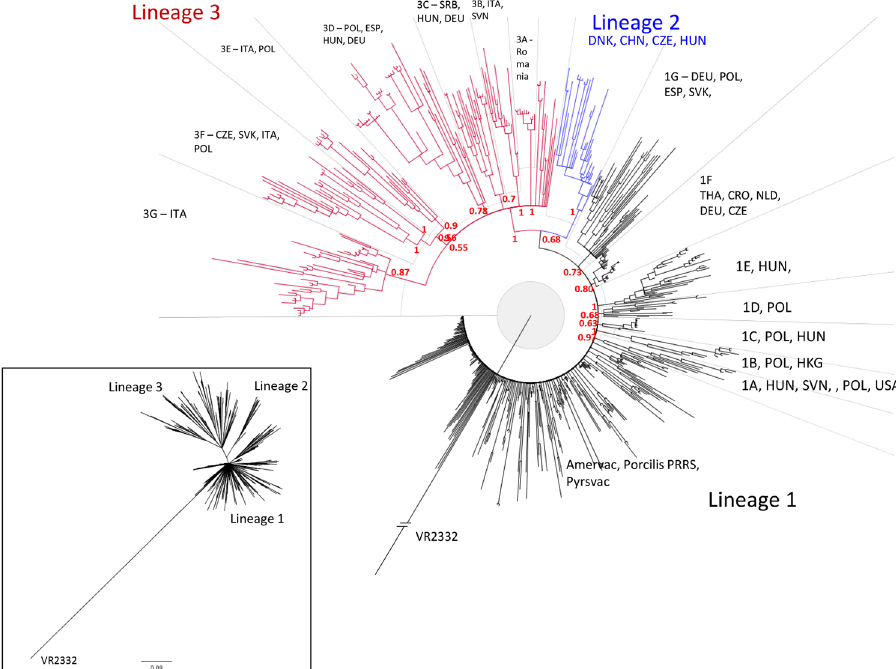
Figure 2. Phylogenetic tree of PRRSV 1 Subtype 1 ORF5 sequences constructed in MrBayes 40 . PRRSV 2 prototype strain VR2332 (AY150564) was used as an outgroup. Three main genetic lineages were distinguished, lineages 1 and 3 containing further clades 1A–1G and 3A–3G, respectively. General geographical distribution was indicated for main clades and lineage 2. Posterior probability values supporting main nodes were